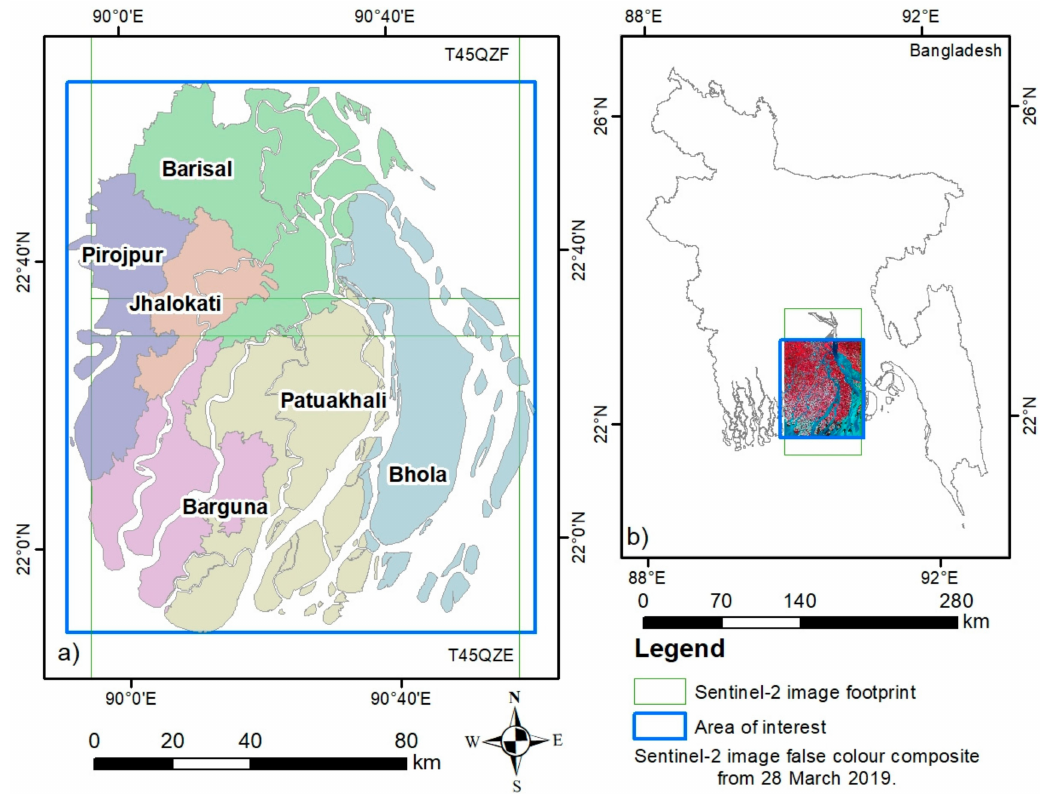
Figure 1. Map of Barisal division in costal Bangladesh with its six districts ( a ). The footprint of the two Sentinel-2 tiles T45QZE and T45QZF, which limit the extent of our study area, is also shown ( b